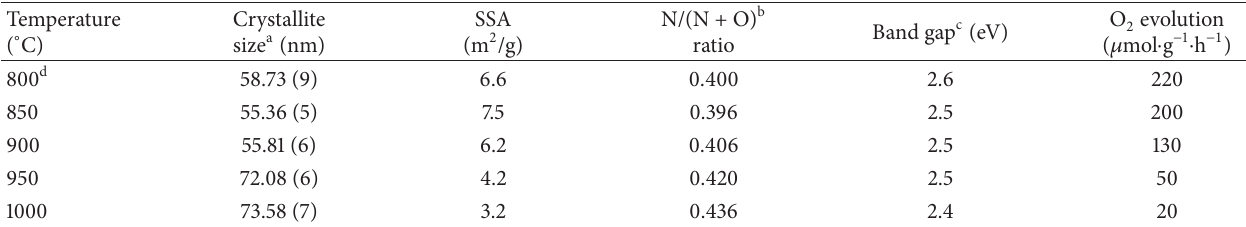
Table 2: Crystallite size, specific surface area (SSA), nitrogen content, band gap, and O different nitridation temperatures.